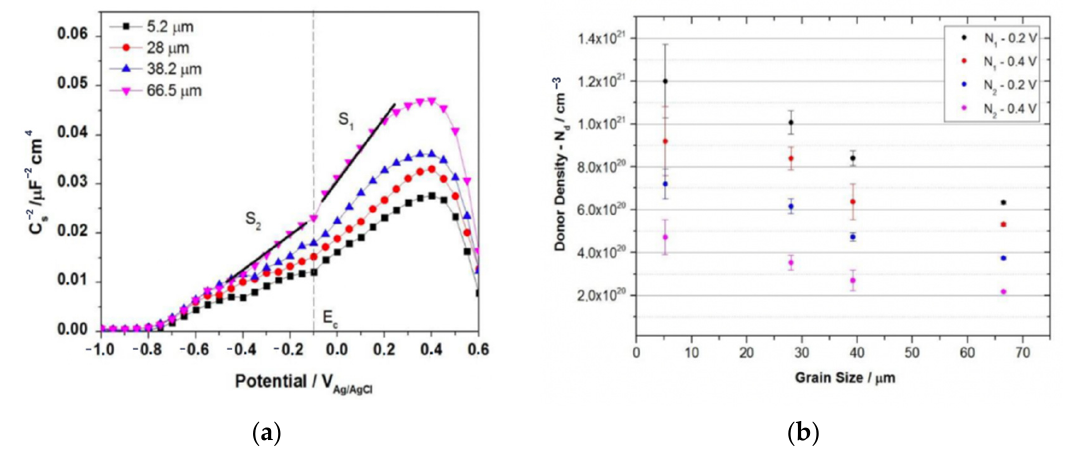
Figure 10. ( a ) Mott–Schottky plot of samples after forming passive layer at 0.4 V for 6 h. ( b ) Donor density values of the passive layers formed at both 0.2 and 0.4 V for 6 h.